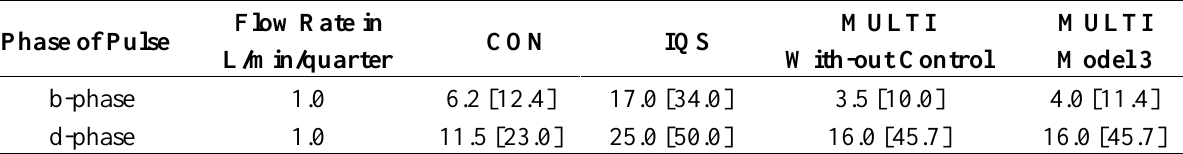
Table 3. Comparison of vacuum reduction data in kPa and in (%) of machine vacuum of a CON and an IQS milking system taken from a study by O’Callaghan and Berry [34], with the data of MULTI, with and without control system, collected for the present